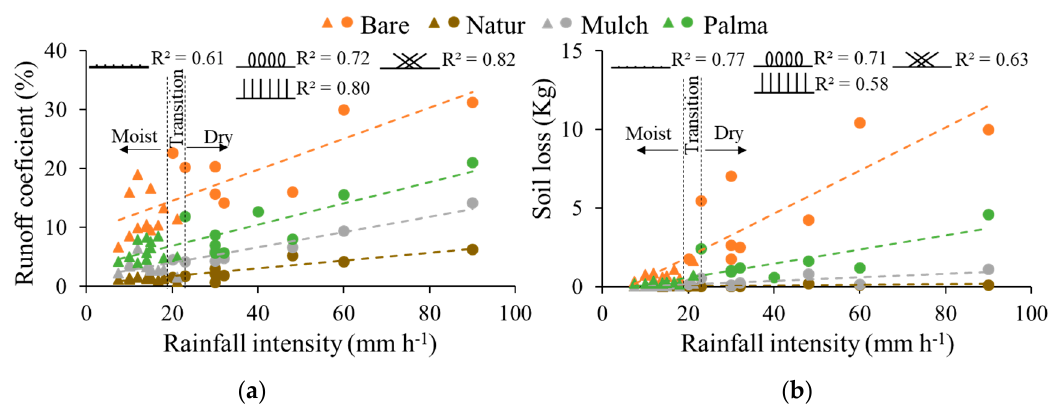
Figure 8. Runoff coefficient ( a ) and soil loss ( b ) for all sites and all rainfall events. Antecedent soil moisture conditions are indicated by triangles, representing high antecedent soil moisture (moist conditions), and circles, representing low antecedent soil moisture (dry conditions).